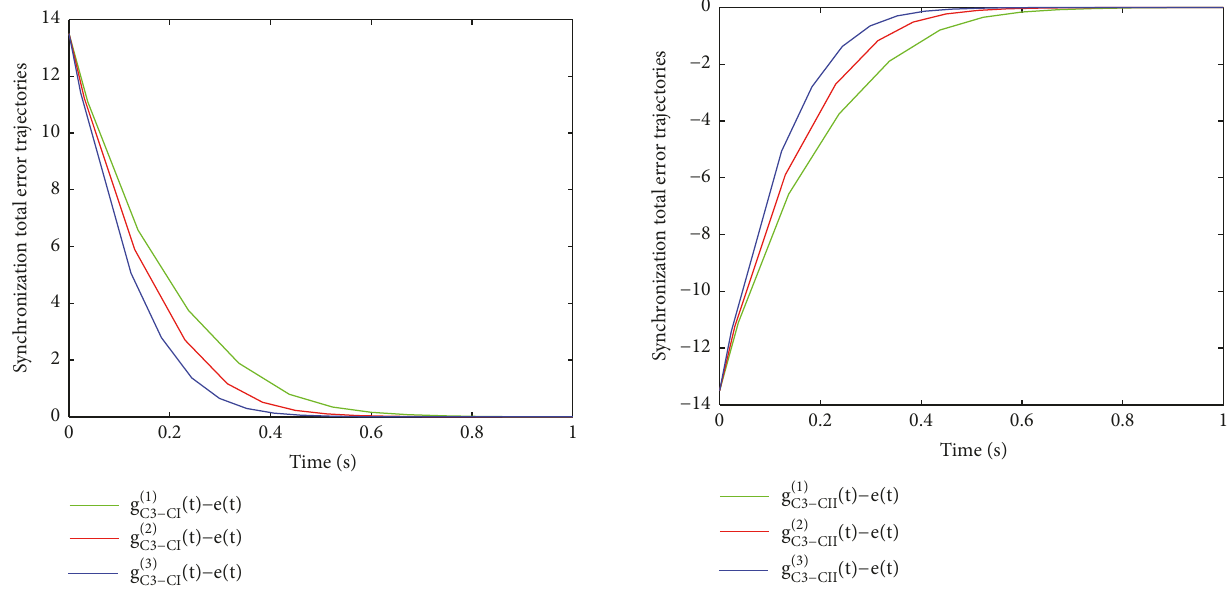
Figure 2: Synchronization total error trajectories of the network (36) for the case I of Corollary 20.